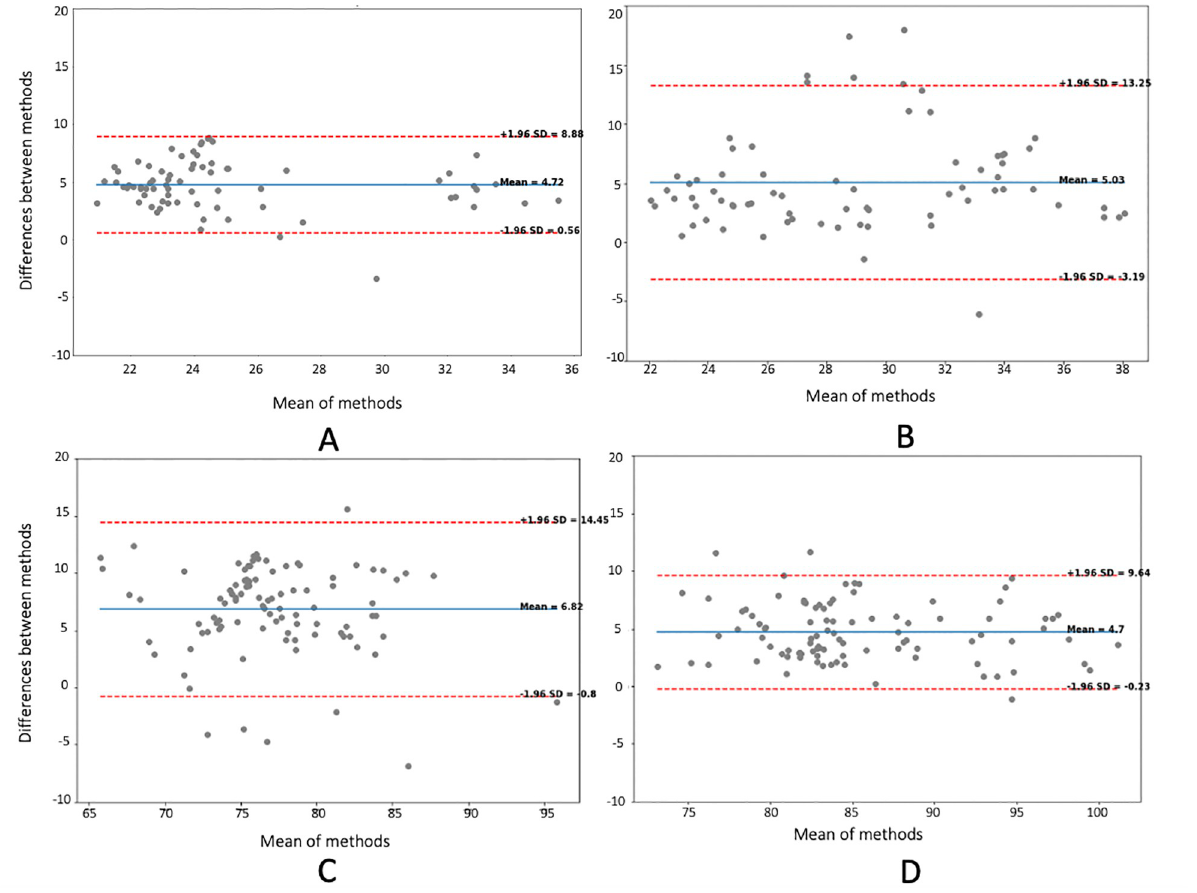
Fig 10. Bland-Altman (BA). BA plots showing the total active flexion mean for A) abduction and adduction, B) radial walking, C) metacarpophalangeal flexion, and D) thumb opposition of the 2nd, 3rd, 4th and 5th digits for the metacarpophalangeal and proximal interphalangeal joints of the left and the right